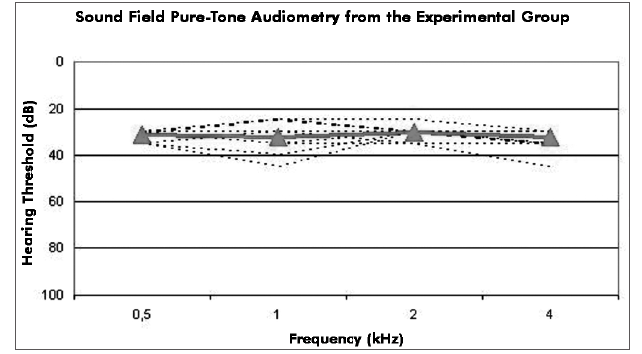
Figure 1. Free Field Pure Tone Audiometry - Results of free field auditory thresholds (dB) at 0.5, 1, 2, and 4 kHz.